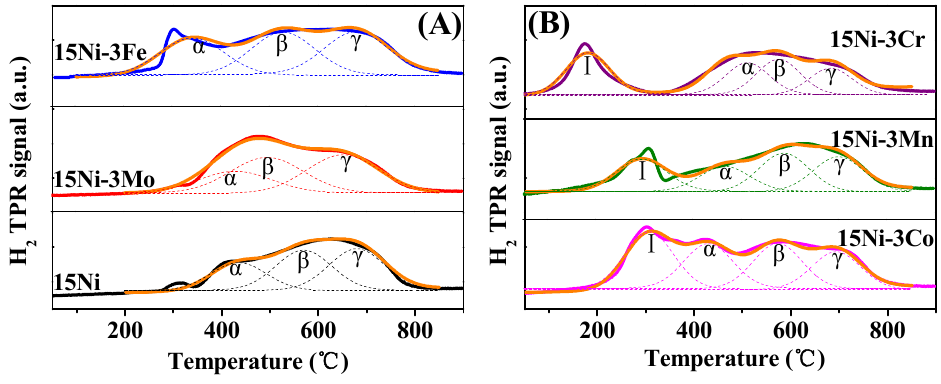
Figure 3. TPR profiles of the as ‐ prepared catalysts ( A ) and ( B ).